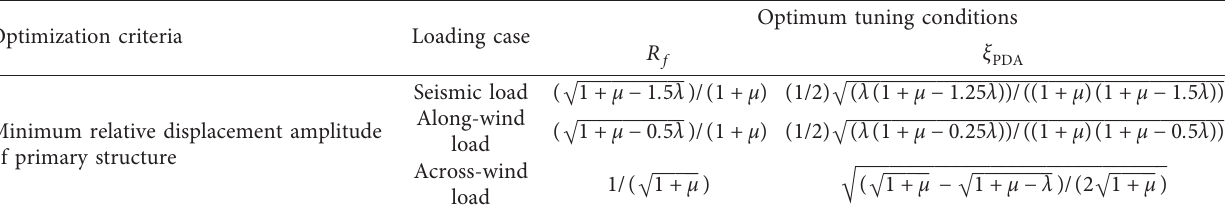
Table 2: Optimum tuning conditions for TLDs attached to an undamped primary structure. Optimization